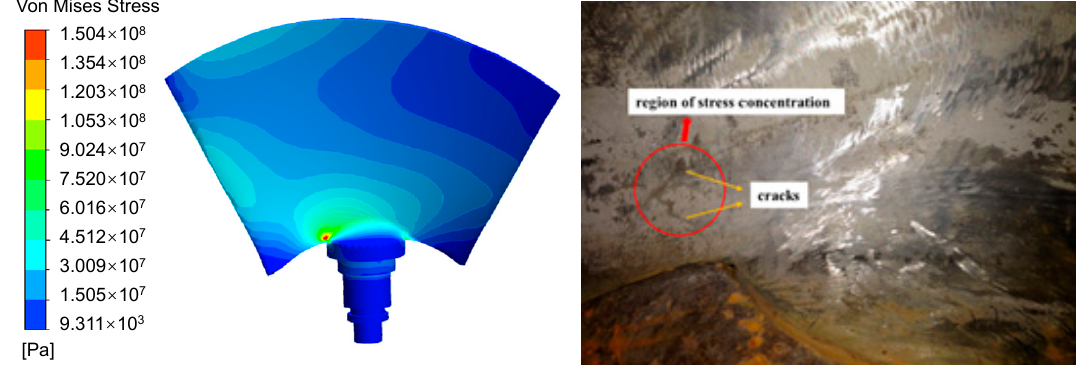
Figure 8. Comparison of the simulated stress distribution of the impeller blade suction side at φ = 0° and cracks on the prototype impeller blade, ( a ) simulated region of stress concentration, ( b ) clustered cracks on the prototype impeller blade.